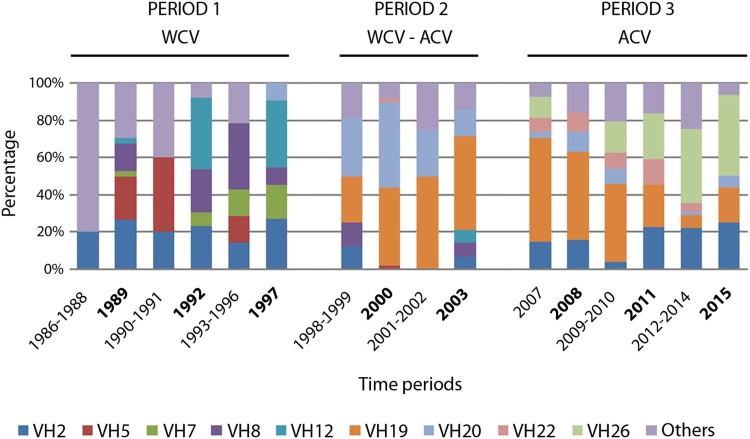
Temporal distribution of PFGE profiles of B. pertussis circulating in the metropolitan area of Barcelona from 1986 to 2015. WCV: Whole cell vaccine; ACV: Acellular vaccine; Bold-face type is used to indicate epidemic years.